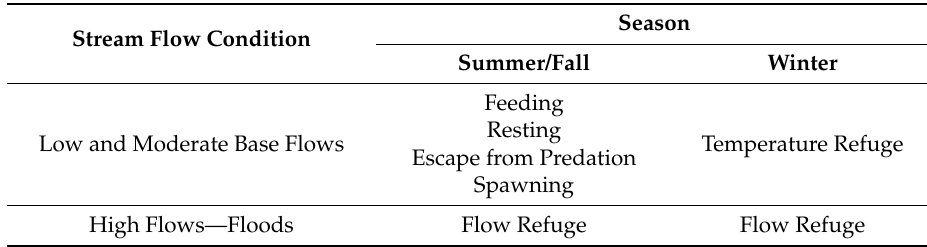
Table 1. Basic biological needs or trait strategies for fish guilds organized by flow condition and season: an example for low-gradient alluvial streams in the Midwest